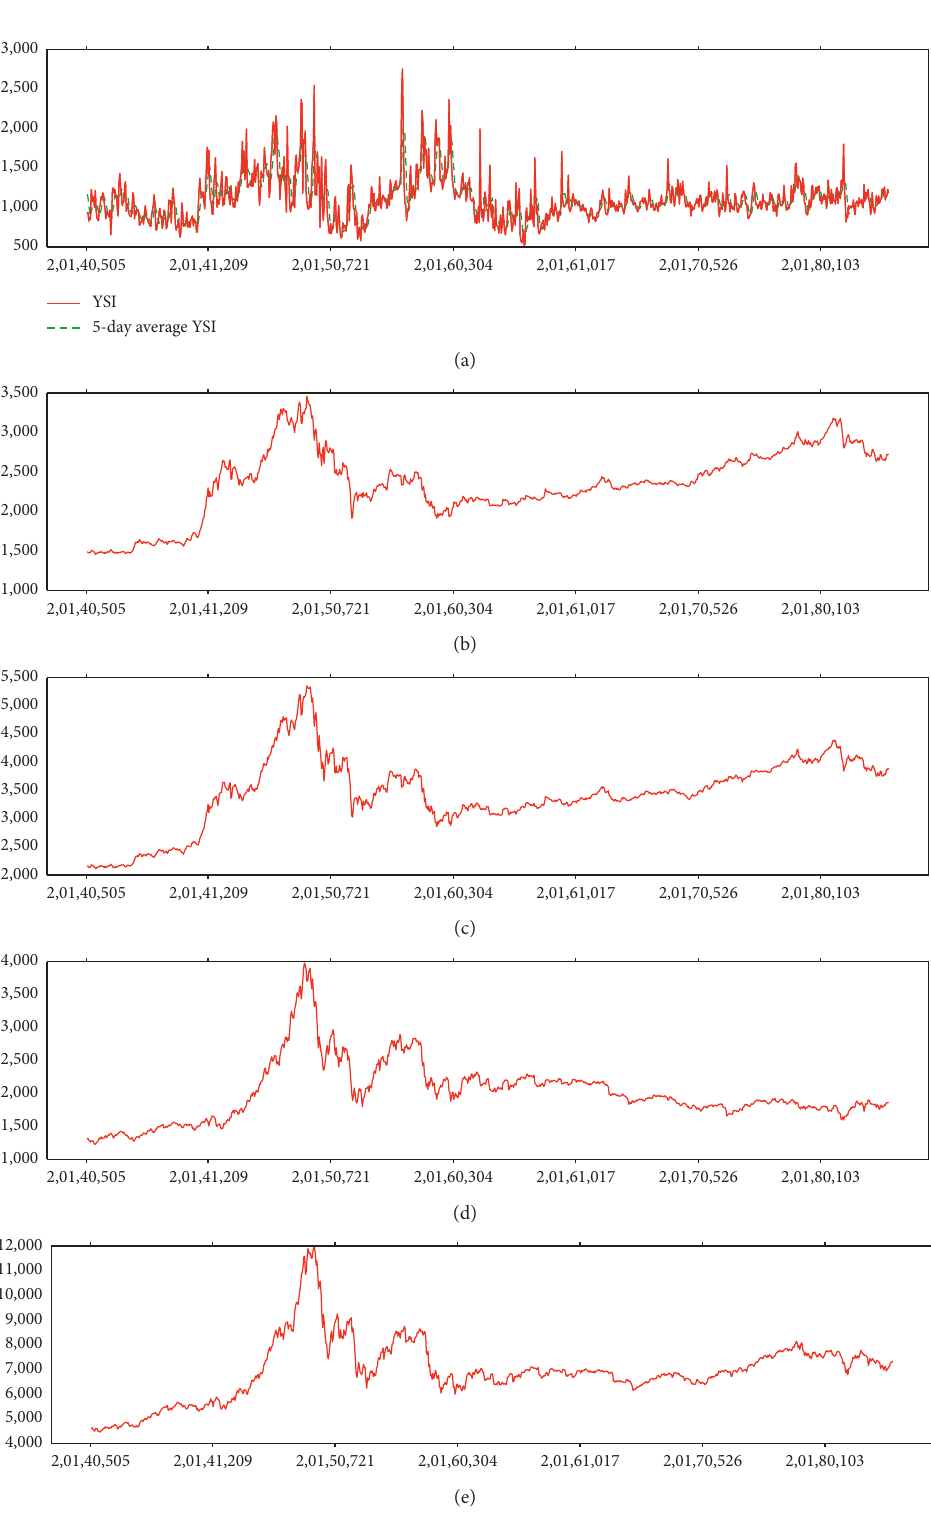
Figure 1: Time series of (a) YSI, (b) SSE50, (c) CSI300, (d) GEM, and (e) SME from May 1, 2014, to May 10,